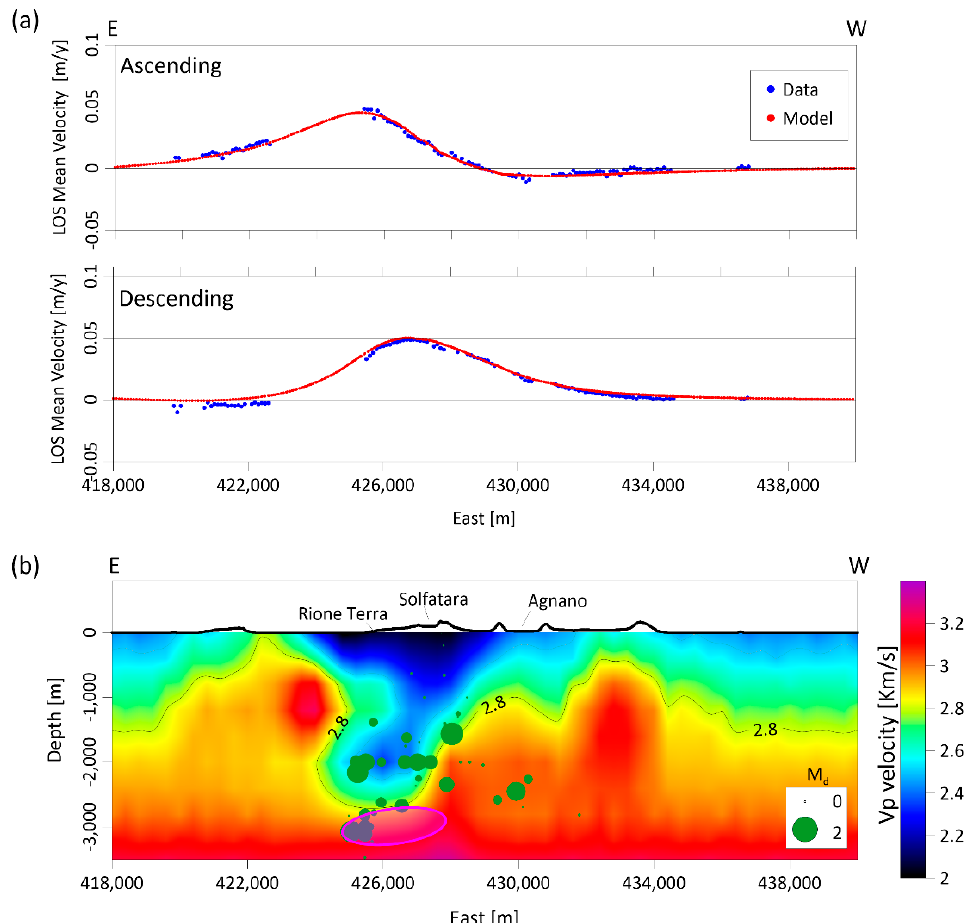
Figure 5. Stationary FE model results. ( a ) Comparison between observed (blue points) and modeled (red points) ascending (top panel) and descending (bottom panel) LOS mean velocity of DInSAR measurements along E–W profile (coordinate N = 4520 km). ( b ) E–W vertical section with the projection of the retrieved source (magenta spheroid), the Vp seismic tomography [22], and the 2011–2013 seismicity. Exaggerated ×2 vertical scale.